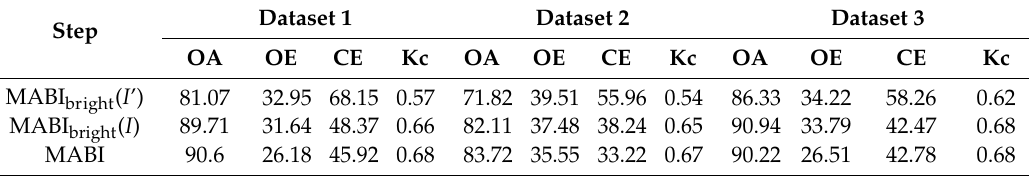
Table 7. Accuracies of the building feature extraction results for each step of the proposed framework.